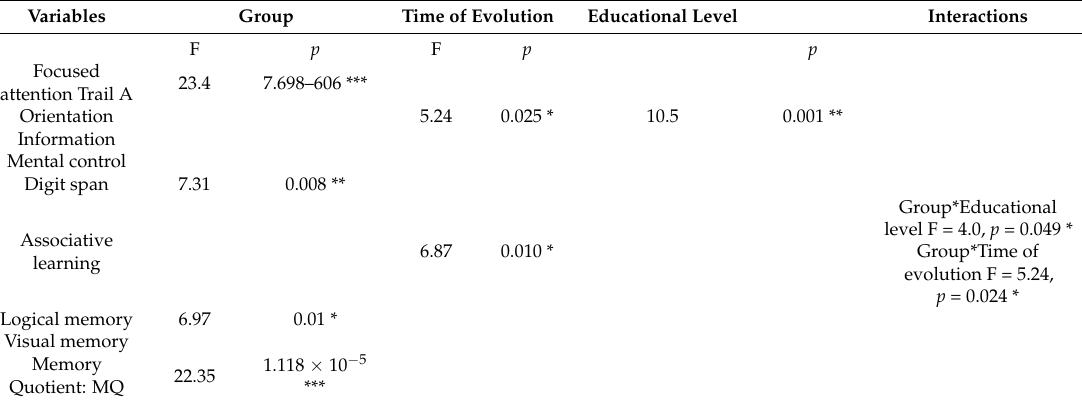
Table 3. Results of the comparison between groups using ANCOVA (fixed effects). Main effects of the Group differences between the differential performance before and after intervention in both groups. Effects of age, time of evolution and educational level and their interaction with group.